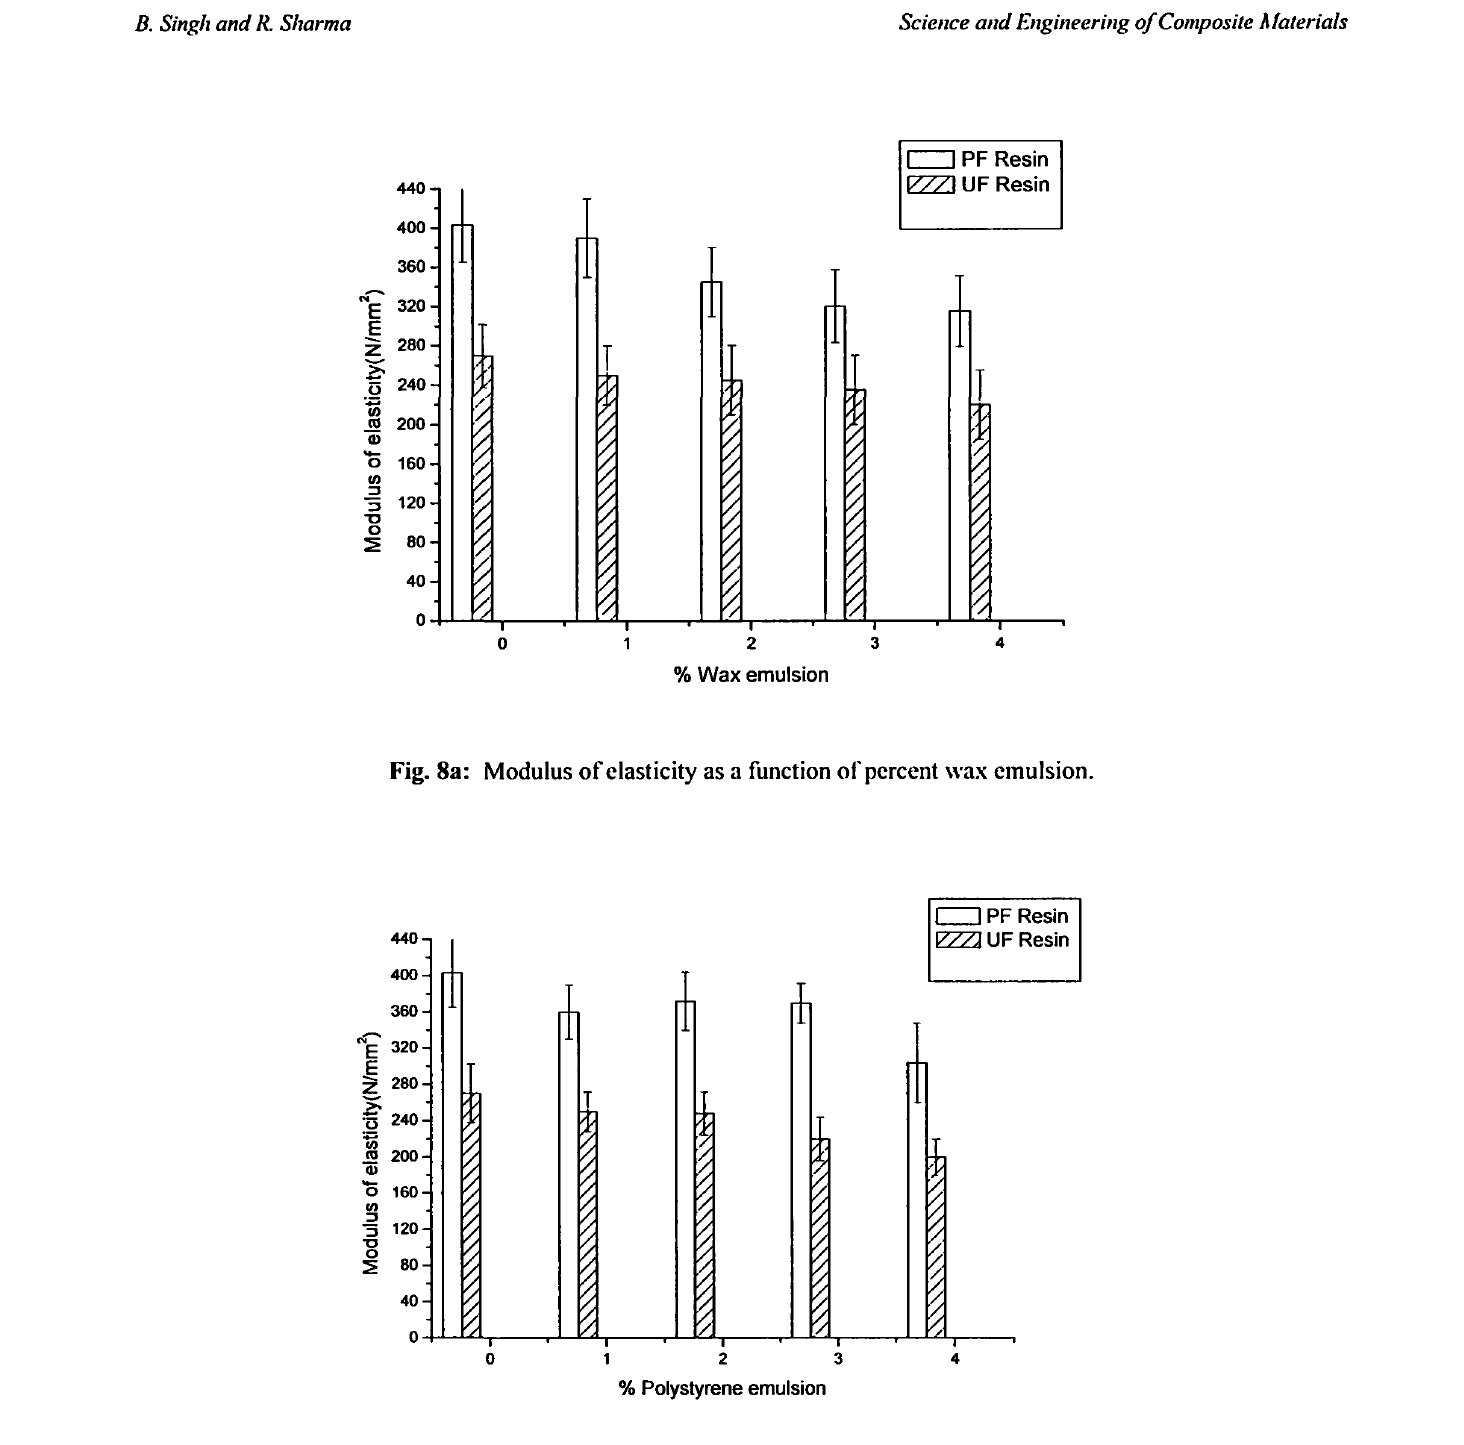
Fig. 8b: Modulus of elasticity as a function of percent Polystyrene